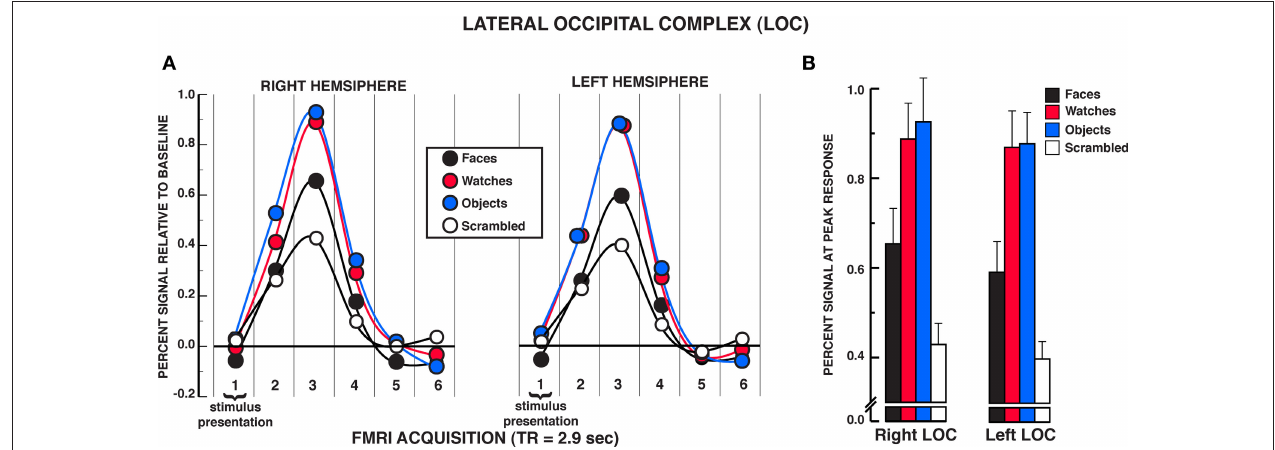
FIguRe 5 | FMRI BOLD results from the individuation task in the LOC regions of interest. (A) Estimated hemodynamic response function (HRF) for the faces, watches, diverse objects, and scrambled stimuli (mean from three individuation task runs) in the LOC. See Figure 3 for detailed